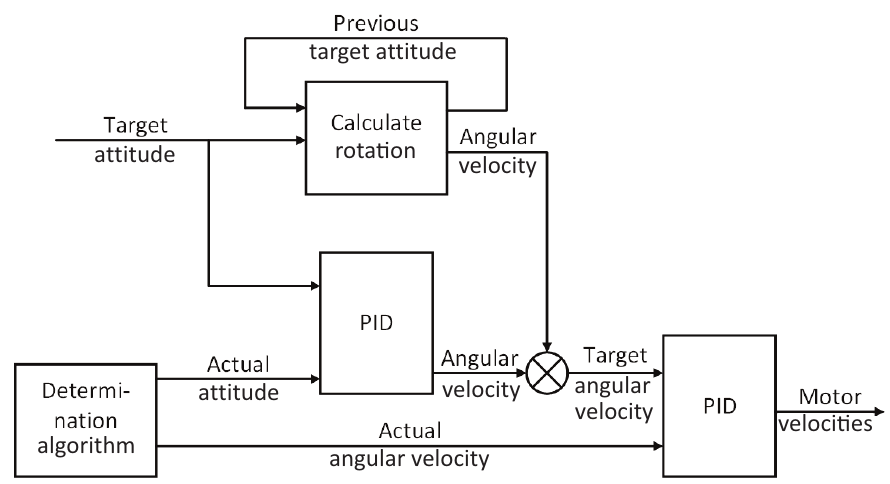
Fig. 8. 3-axis pointing